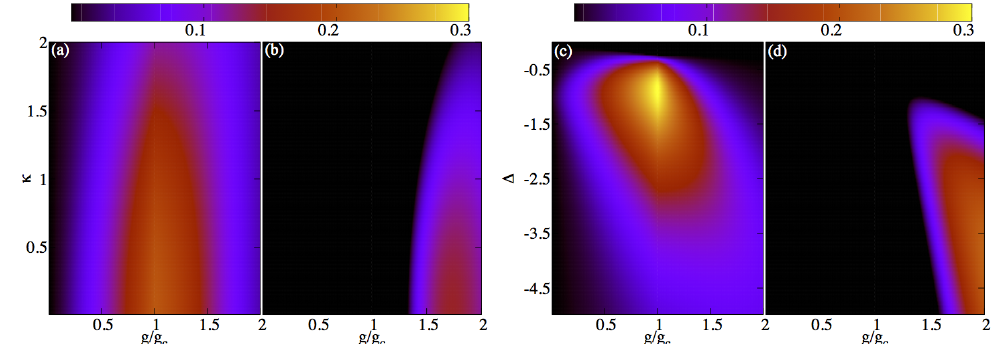
Figure 1. Bipartite entanglement (logarithmic negativity N ) between the cavity mode and each atomic Bose–Einstein condensate (BEC) ( a , c ) and bipartite entanglement between the two atomic BECs ( b , d